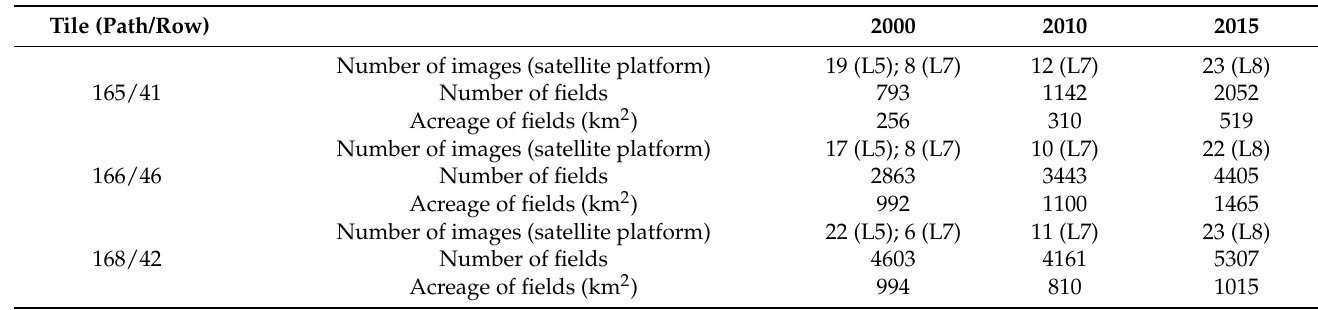
Table 2. The number of Landsat scenes and the Landsat satellite platform (in round brackets) used for each study year and region to perform manual delineation. L4/5/7/8 indicates Landsat 4/5/7/8, respectively. In total, more than 28,000 fields covering 7461 km 2 were manually delineated in Landsat tiles 165/41, 166/46, and 168/42 for years 2000, 2010, and 2015. The location of the tiles is shown in Figure